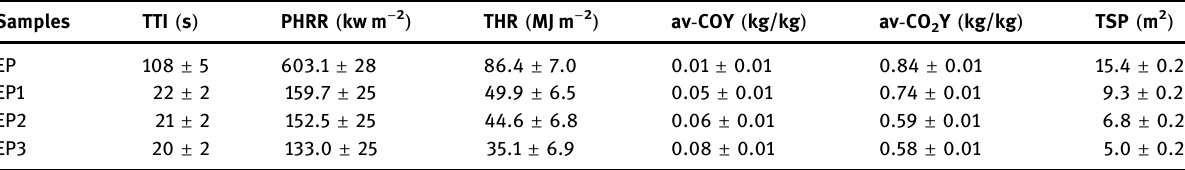
Table 4: Cone calorimeter data of fl ame retarded EP Samples